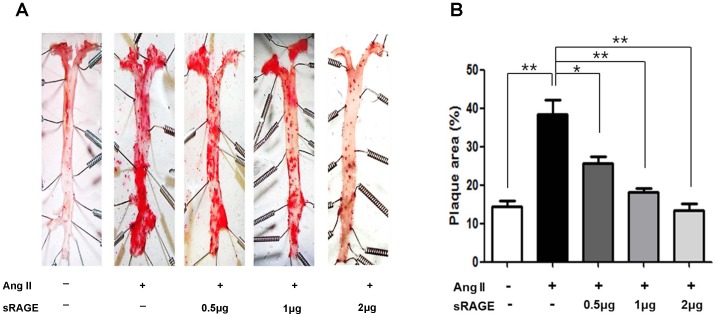
Quantification of Atherosclerotic Lesions.A. Development of atherosclerotic plaque areas in en face aortas (n = 7, representative picture) stained with Oil Red-O stain from Apo E KO mice. B. The percent of atherosclerotic plaque area in the Apo E KO saline injection and in mice that received infusions of AngII with or without various doses of sRAGE. Relative quantification (% plaque area) was performed. *p<0.05 and **p<0.01.